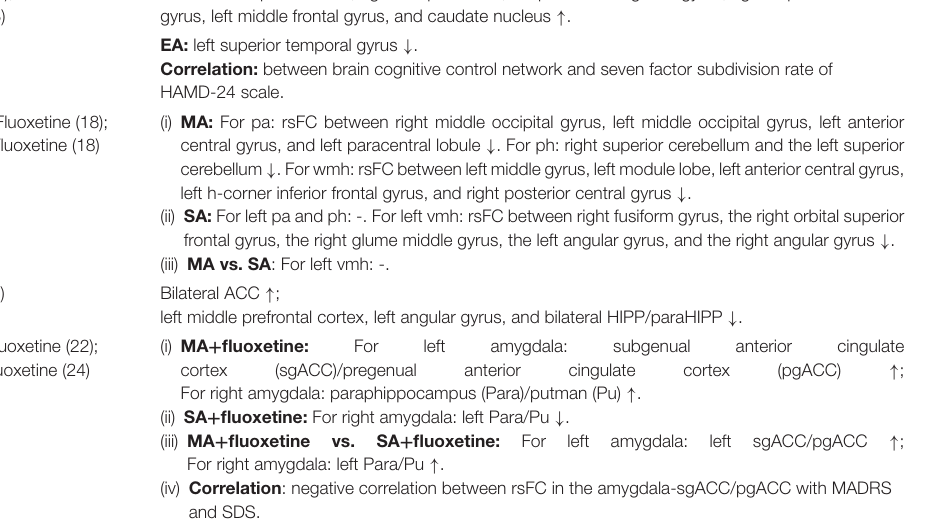
9 (i) EA + placebo drug: bilateral pre-central gyrus, cingulate gyrus and superior frontal gyrus, left FC 2 Depression (9) EA (9) EA: left superior temporal gyrus